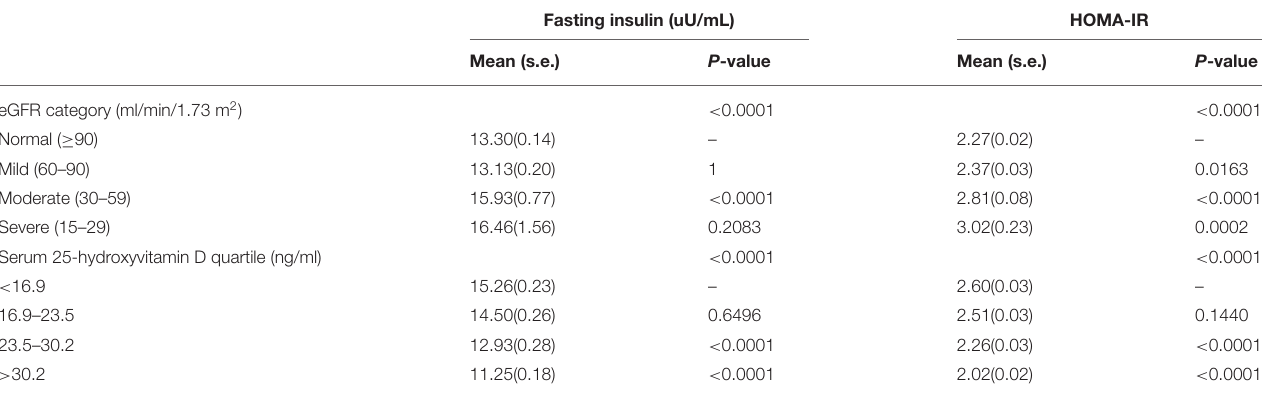
TABLE 4 | Mean (s.e.) levels of fasting insulin levels, and IR.